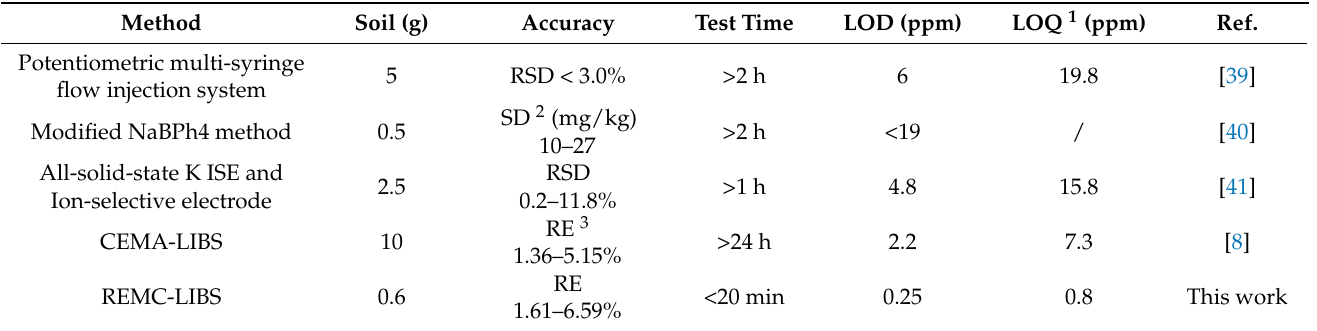
Table 3. Comparison of REMC-LIBS and other methods for the determination of soil available